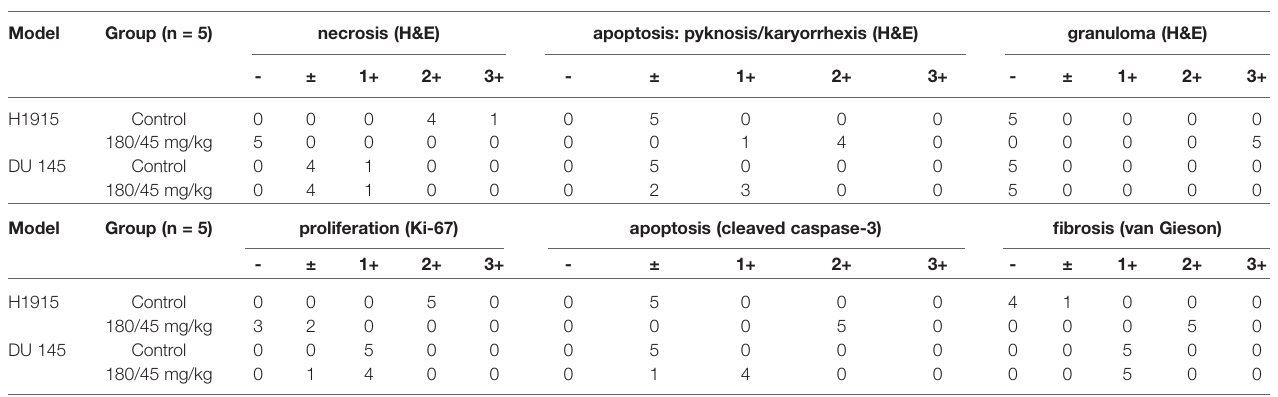
TABLE 3 | Histopathological evaluation, on day 22, of the tumor tissues treated with perifosine. Model Group (n = 5) necrosis (H&E) apoptosis: pyknosis/karyorrhexis (H&E) granuloma (H&E)